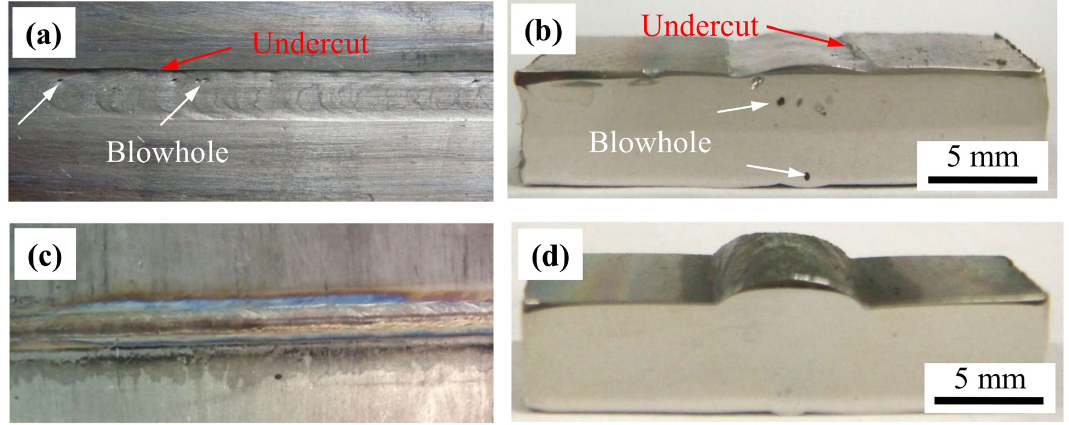
Figure 3. The macro-morphology of two kinds of joints(a)Upper surface of PAW joint(b)Cross-section of PAW joint (c)Upper surface of wire-filled PAW joint (d)Cross-section of wire-filled PAW joint